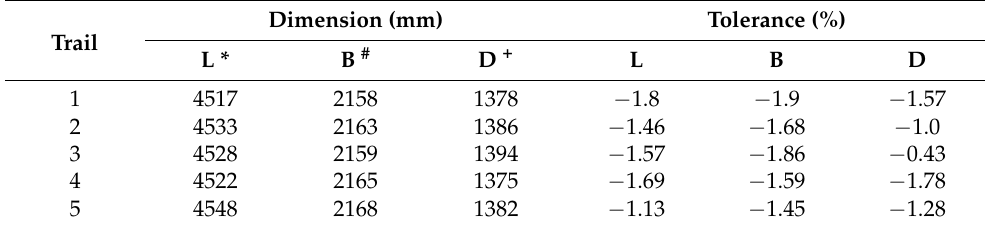
Table 3. Dimensions of bricks.